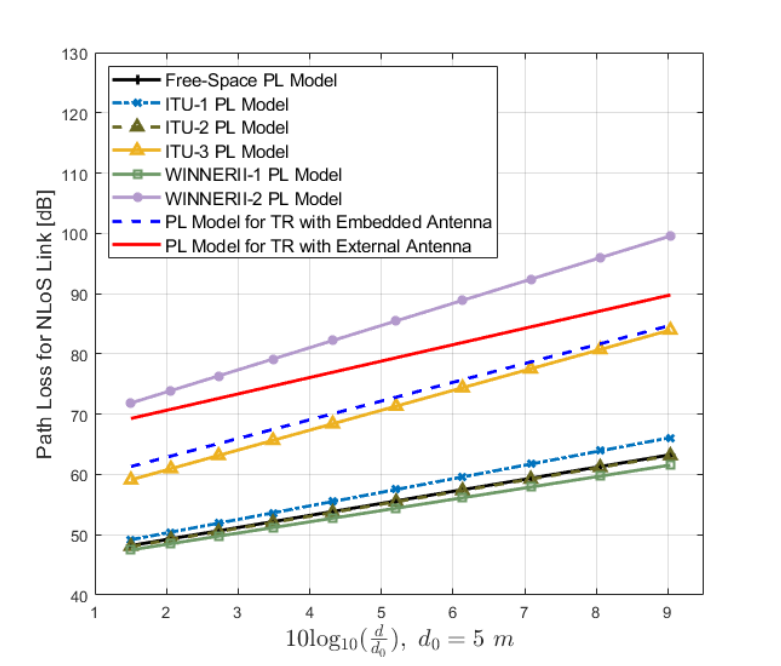
Figure 9. IQRF path loss model comparison with the other model for the Non-Line-of-Sight link.